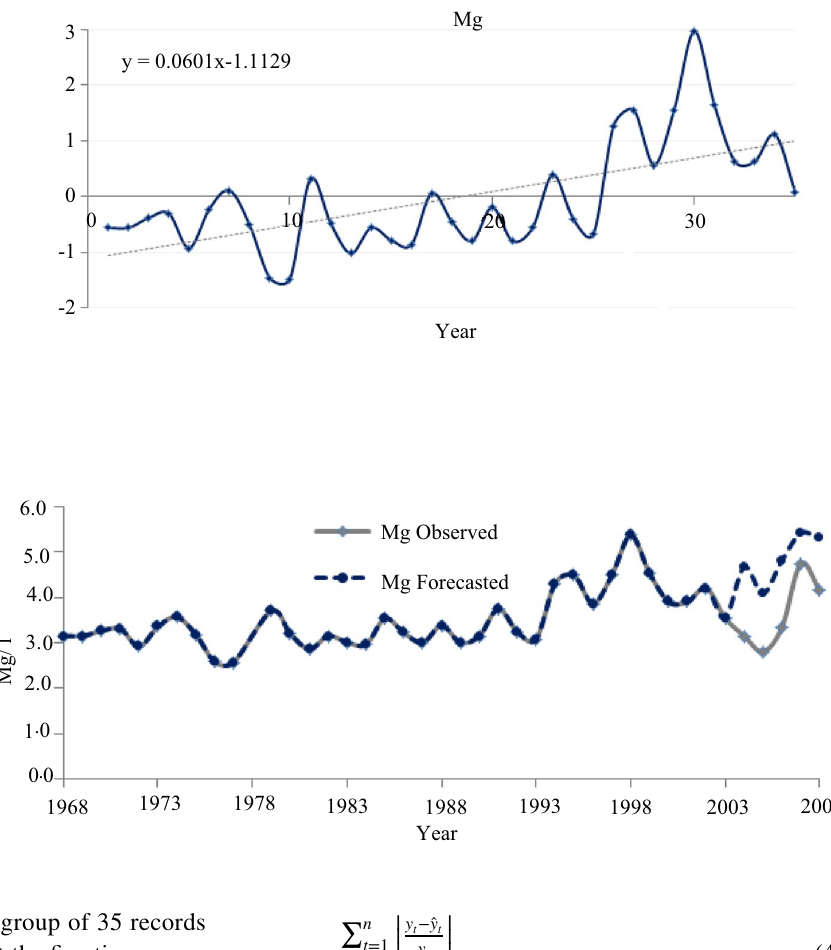
Fig. 8 Unchanging period cat- egorizations of Mg2 + and the forecast values for 5 years